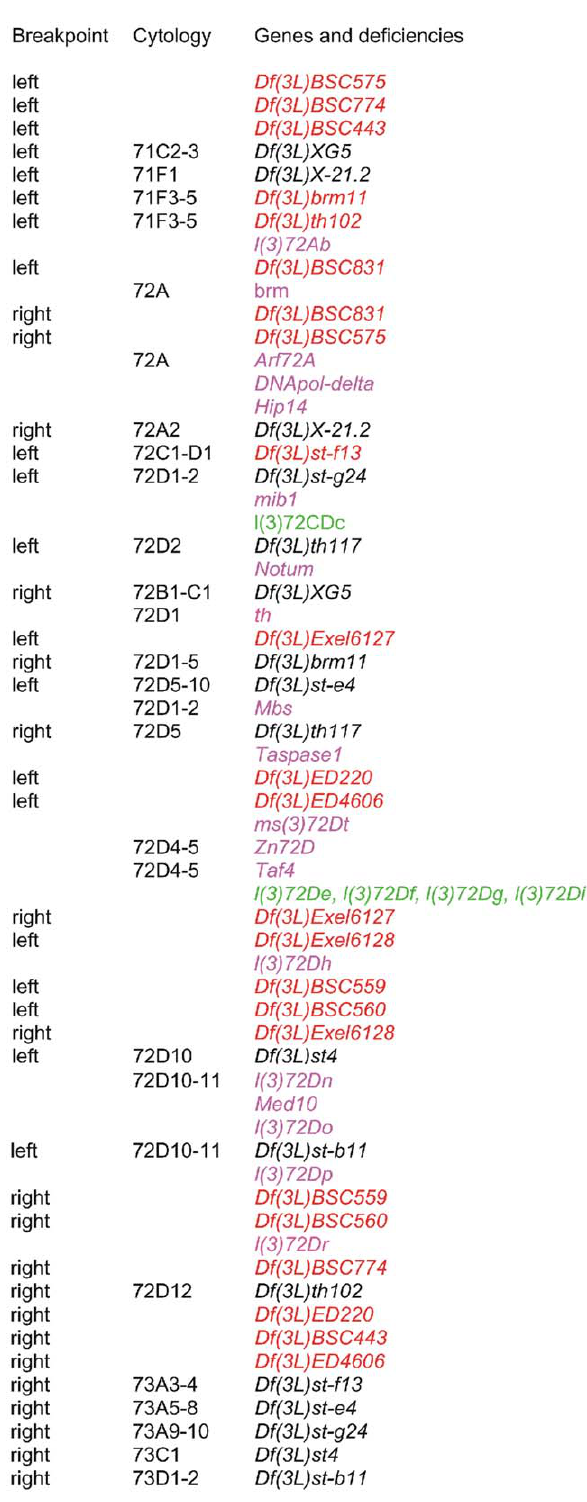
Figure 2. Cytogenetic map showing the deficiencies and genes in polytene chromosome region 72A-D. The cytological locations are only given for deletions or genes mapped on polytene chromo- somes (which do not always correspond to the cytological locations given for the molecular map by the Drosophila Genome Project). Deficiency breakpoints localized on the molecular map are indicated